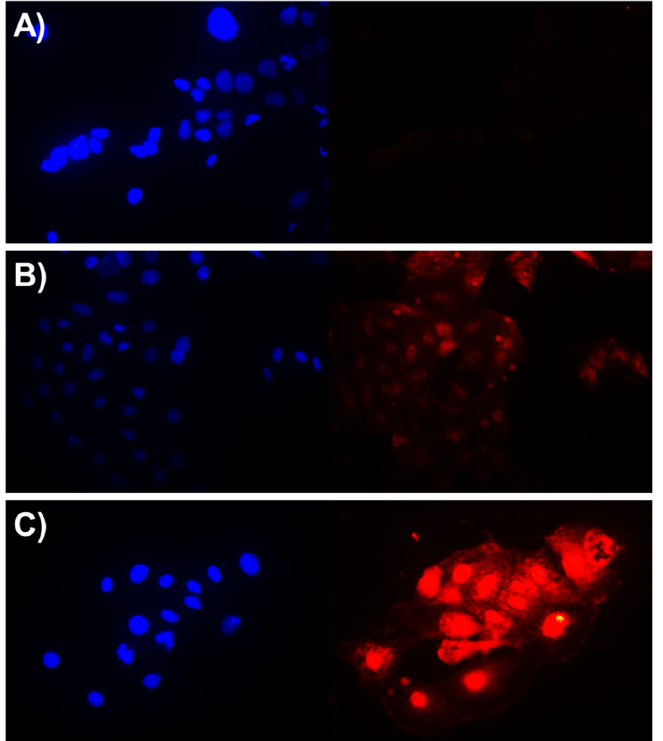
Figure 2. Fluorescence microscopy images of Caco-2 cells treated with IC 50 values of TAMRA- labeled peptides for 5 h: ( A ) untreated control; ( B ) TAMRA-labeled mCA4-4; ( C ) TAMRA-labeled mCA4-5.